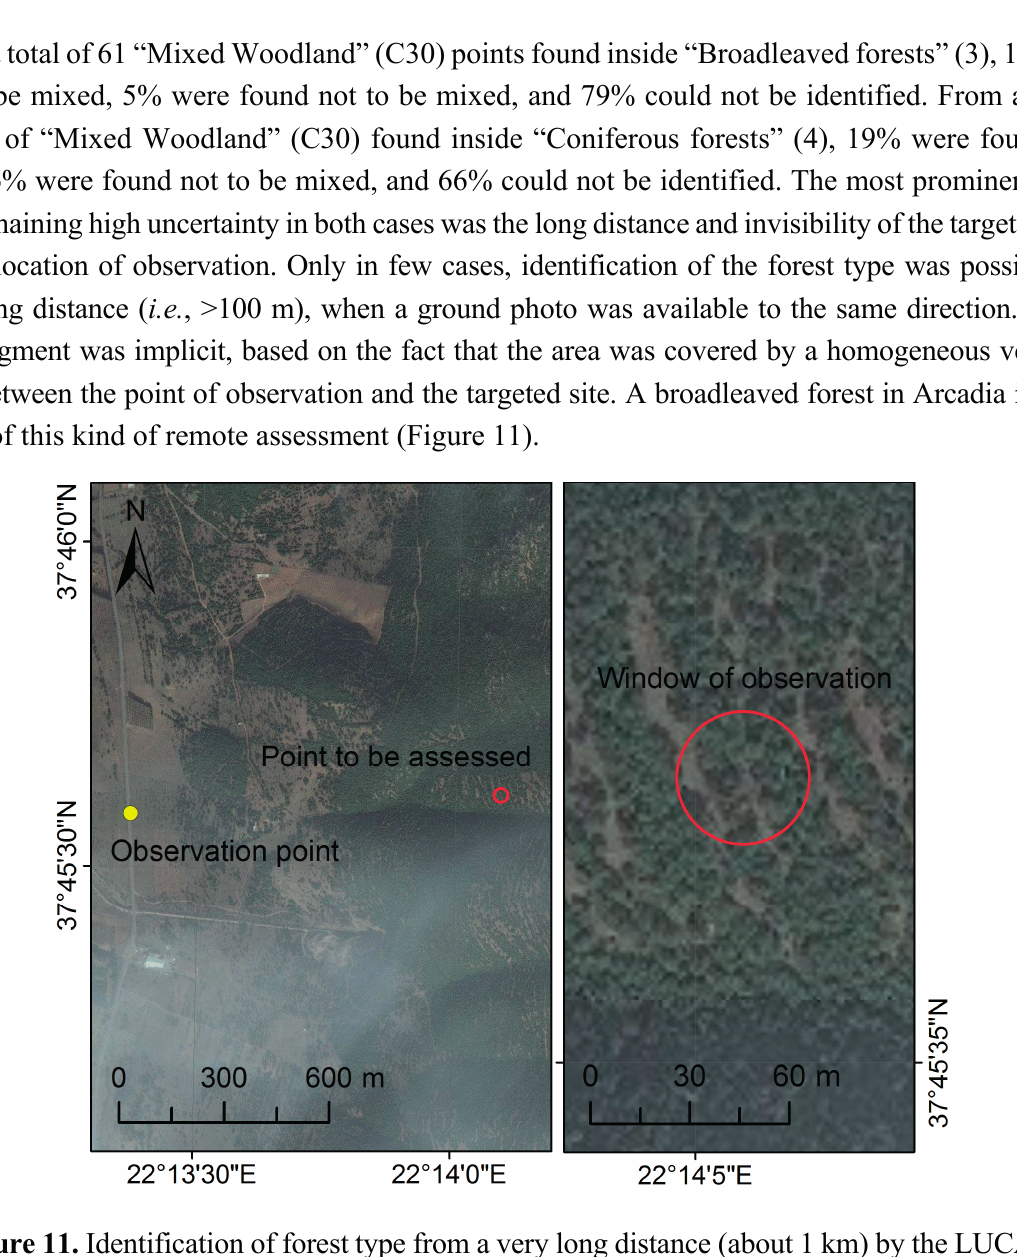
Figure 11. Identification of forest type from a very long distance (about 1 km) by the LUCAS surveyors in Arcadia, possibly using far ground pictures and available air photos; the assessment (“Broadleaved and Evergreen Woodland”, C10) verifies the WWF Hellas